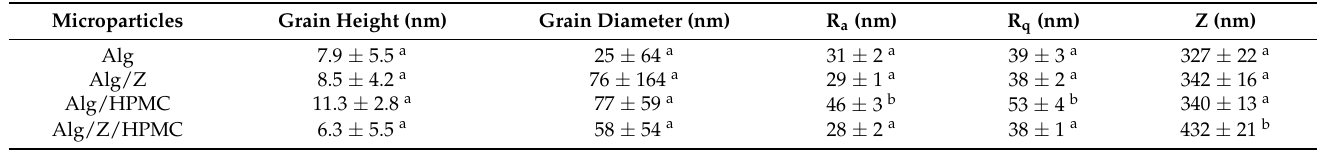
Table 4. Roughness parameters of the microparticle surfaces (grain mean height, grain mean diameter, average roughness—R a , root mean square of roughness—R q and Z range for microparticles loaded with rosemary